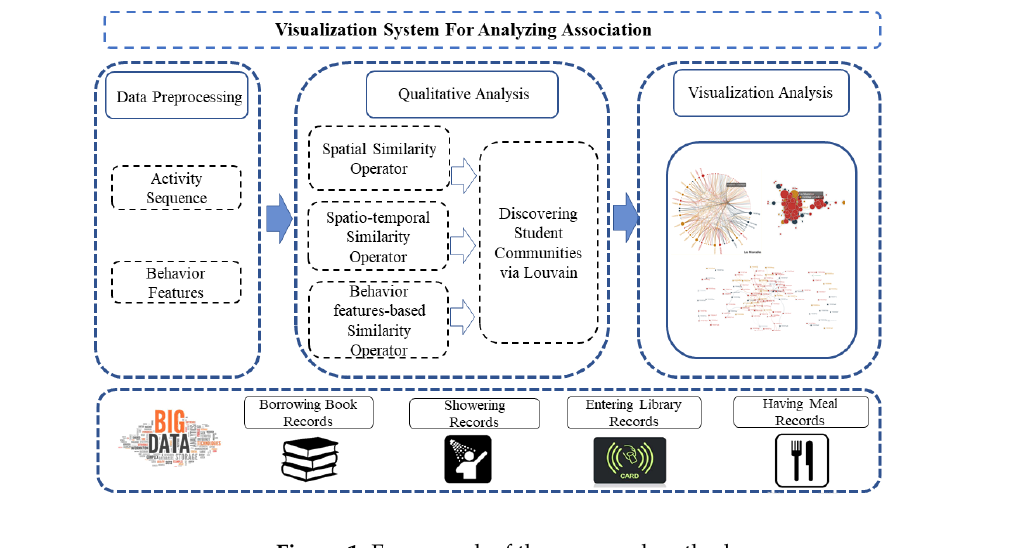
Figure 1. Framework of the proposed